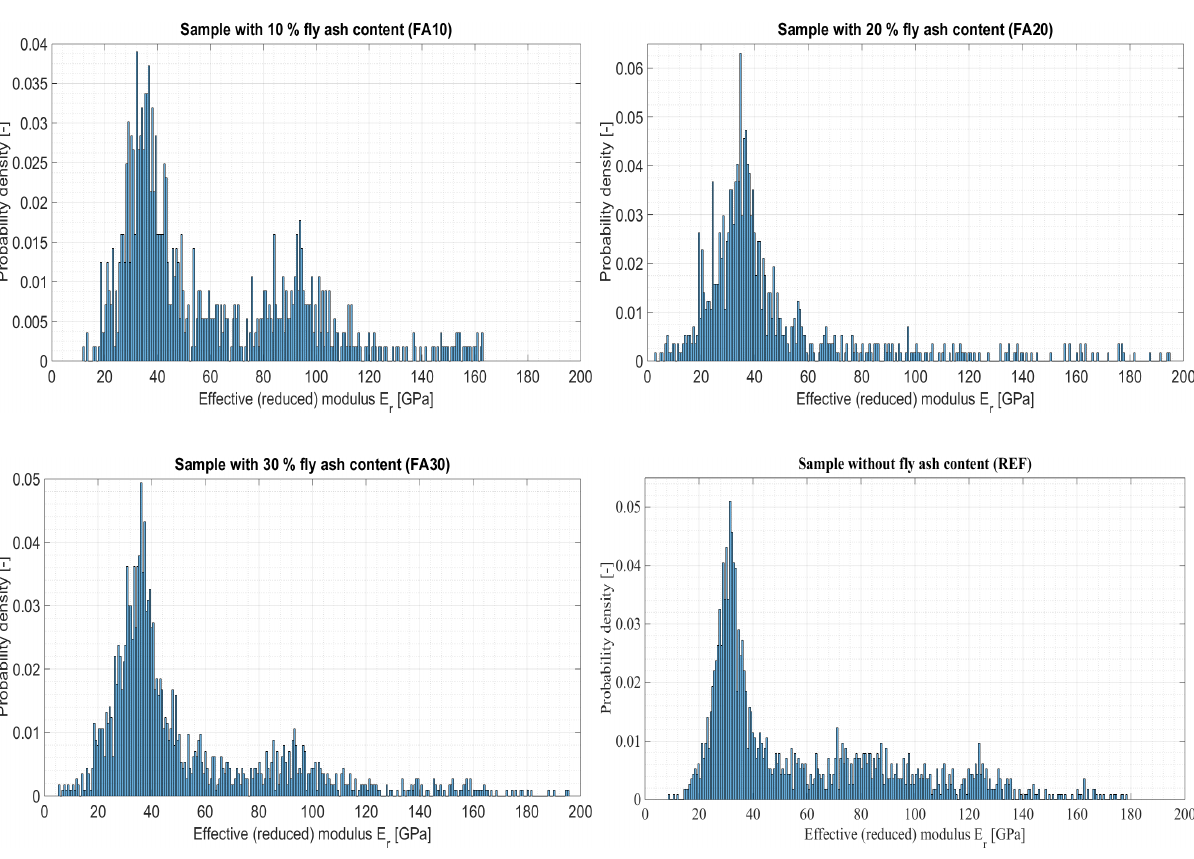
Figure 2. Histograms of indentation modulus E